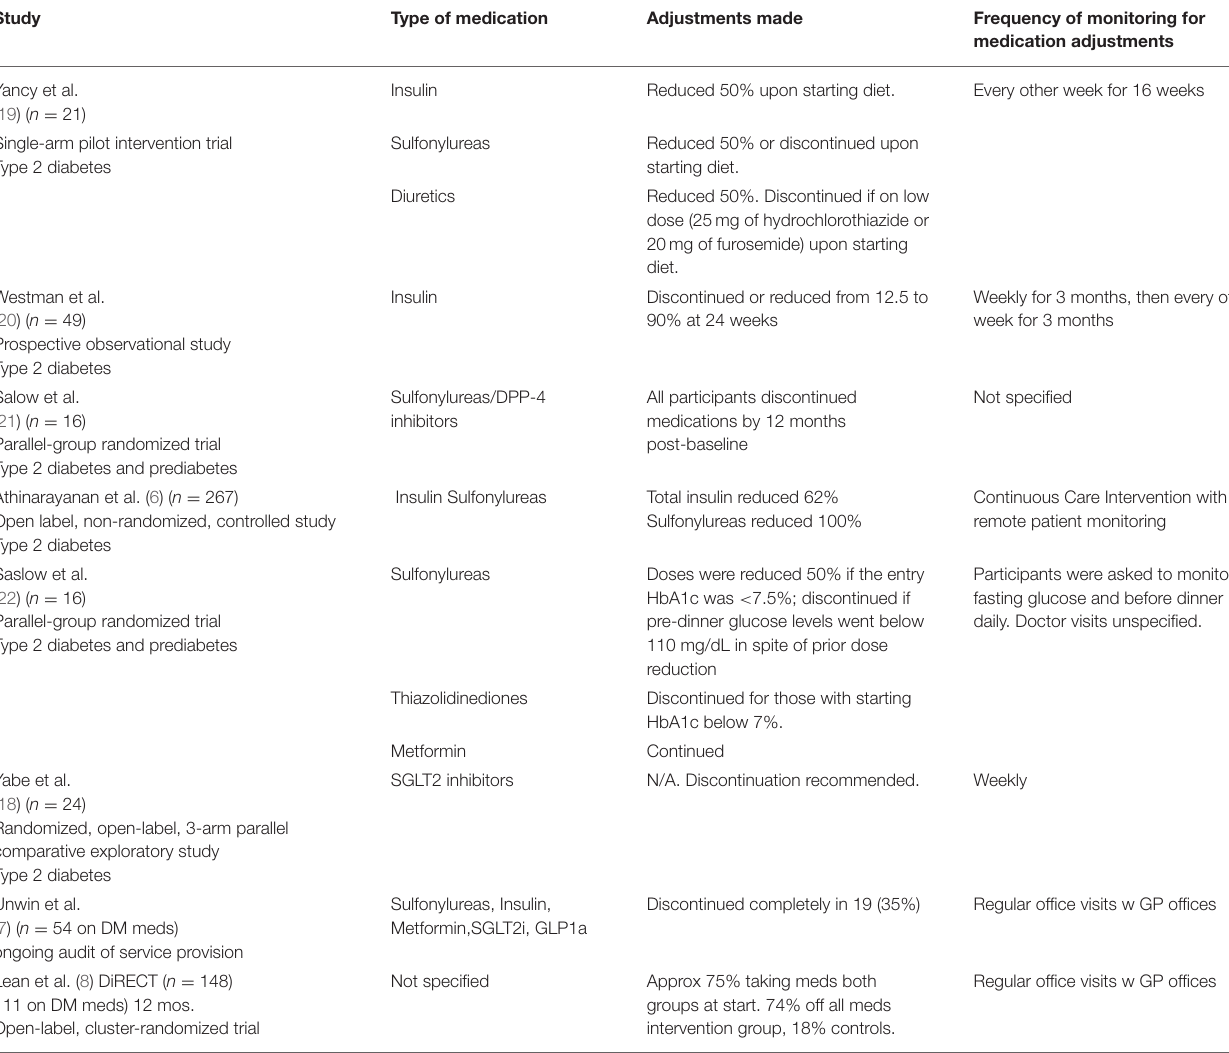
TABLE 1 | Medication adjustments for LCD meal plans summary of studies.